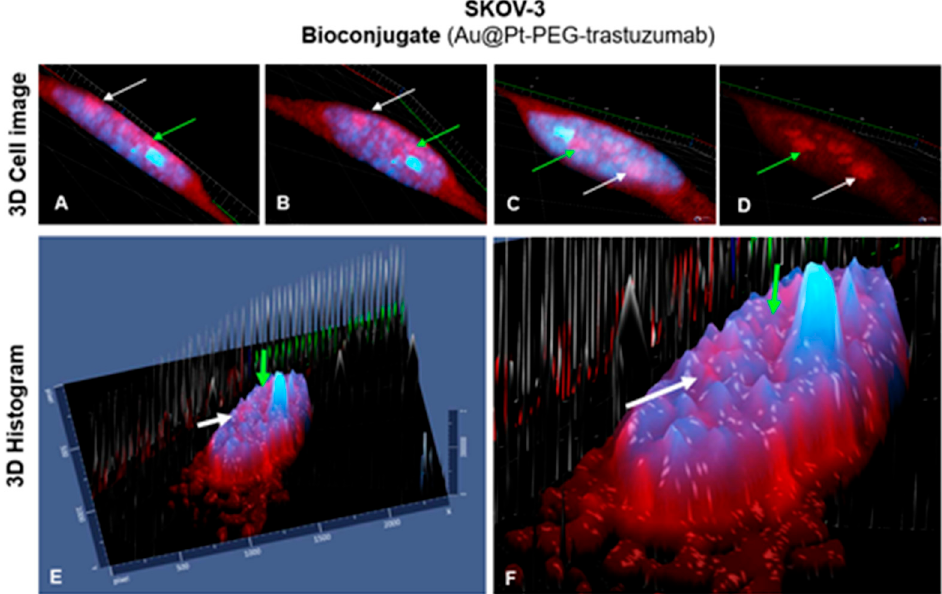
Figure 12. 3D confocal images of SKOV-3 cell treated with Au@Pt-PEG-trastuzumab bioconjugate. Corresponding signals are marked with green and white arrow in each picture, respectively. ( A – D ) 3D images of differently rotated cell; ( E , F ) 3D histograms.